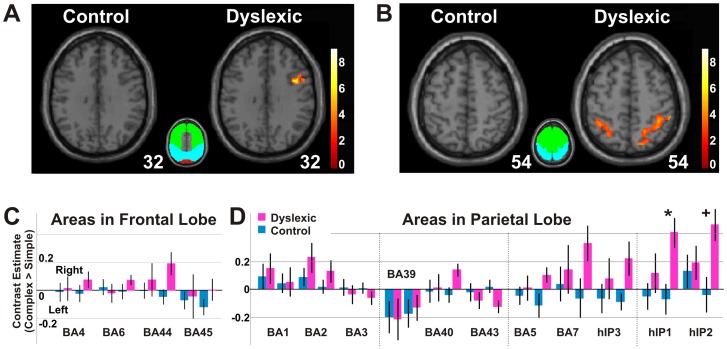
Activations in fronto-parietal regions.(A) Brain images illustrate frontal activations for control and dyslexic groups (Complex>Simple, p<0.05, cluster corrected for frontal lobe). There is one activation cluster for the dyslexic group, and none for the control group. (B) Brain images for parietal activations (Complex>Simple, p<0.05, cluster corrected for parietal lobe) indicates that in contrast to bilateral activation for the dyslexic group, there is none for the control group. In both A and B, the color bar depicts t values, and the color inset illustrates the subdivisions of occipital (red), frontal (green) and parietal (cyan) lobes. The transverse images are shown at 32 and 54 mm above the AC-PC level, respectively. (C) Anatomically determined ROI analysis shows activations for control and dyslexic groups. (D) Anatomically determined ROI analysis shows that the activation of area hIP1 in the dyslexic group is significantly greater than in the control group. From left to right, the parietal areas are shown in four groups: precentral gyrus (BA1, BA2, and BA3), inferior parietal lobule (BA39, BA40, and BA43), superior parietal lobule (BA5, BA7 and hIP3), and intraparietal sucus (hIP1 and hIP2). +
p<0.10; * p<0.05; Bonferroni corrected t-test. Error bars represent SEM within group.